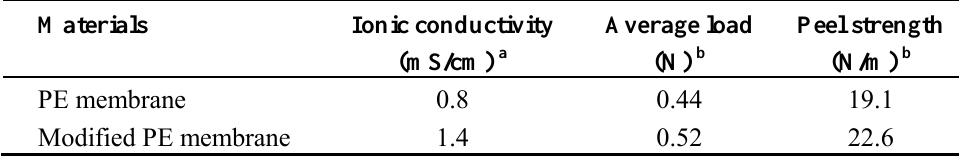
Table 5 . Ionic conductivity and peel test results for PE and the modified PE membranes. Reproduced with permission from Reference [58]. © 2009 Elsevier